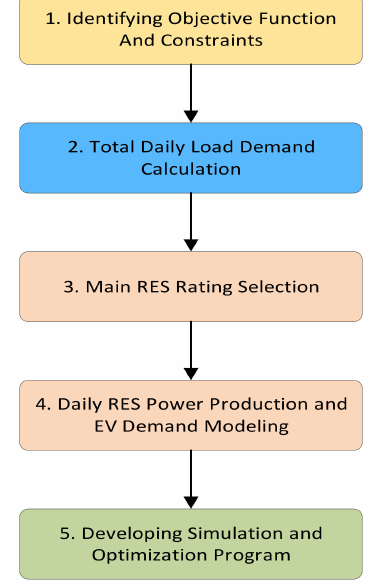
Figure 4. Methodology followed for optimizing the electricity supply to Electric Vehicle (EV) Fast Charging Stations